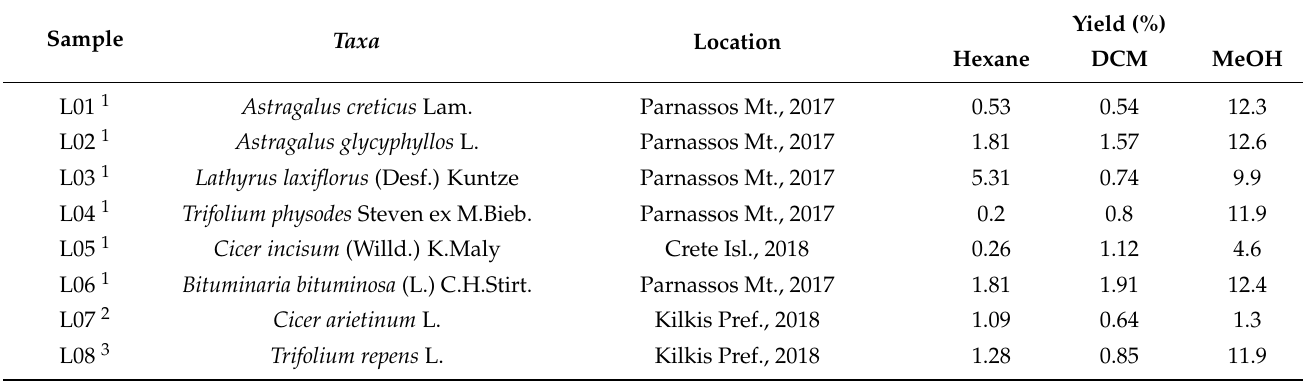
Table 1. Samples’ composition and extraction